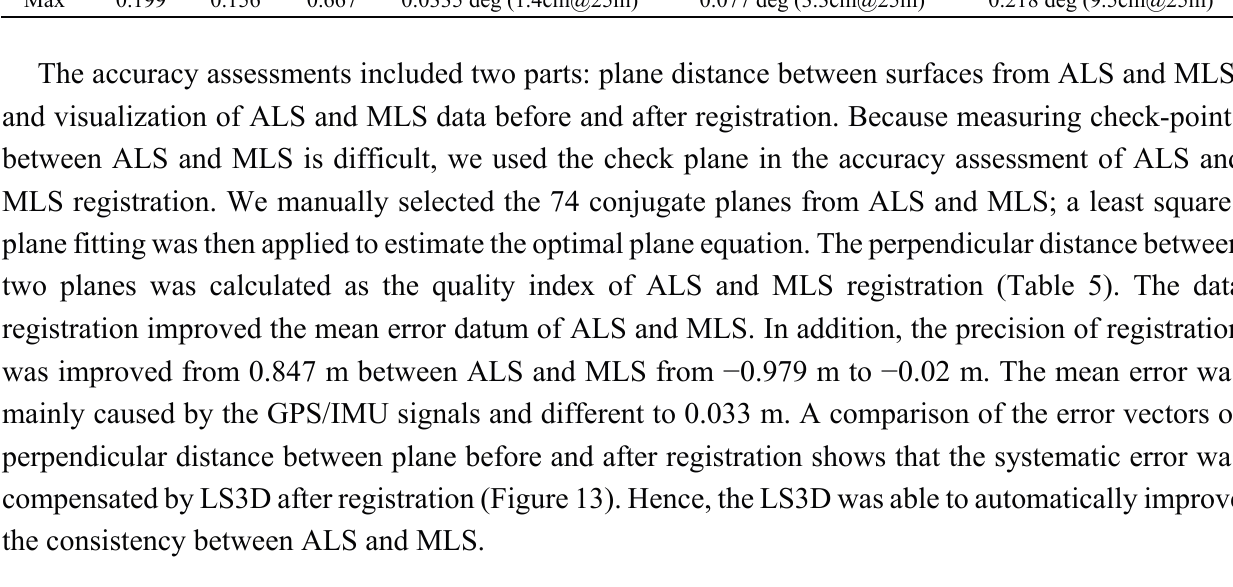
Figure 13. Error vectors of plane distance before and after